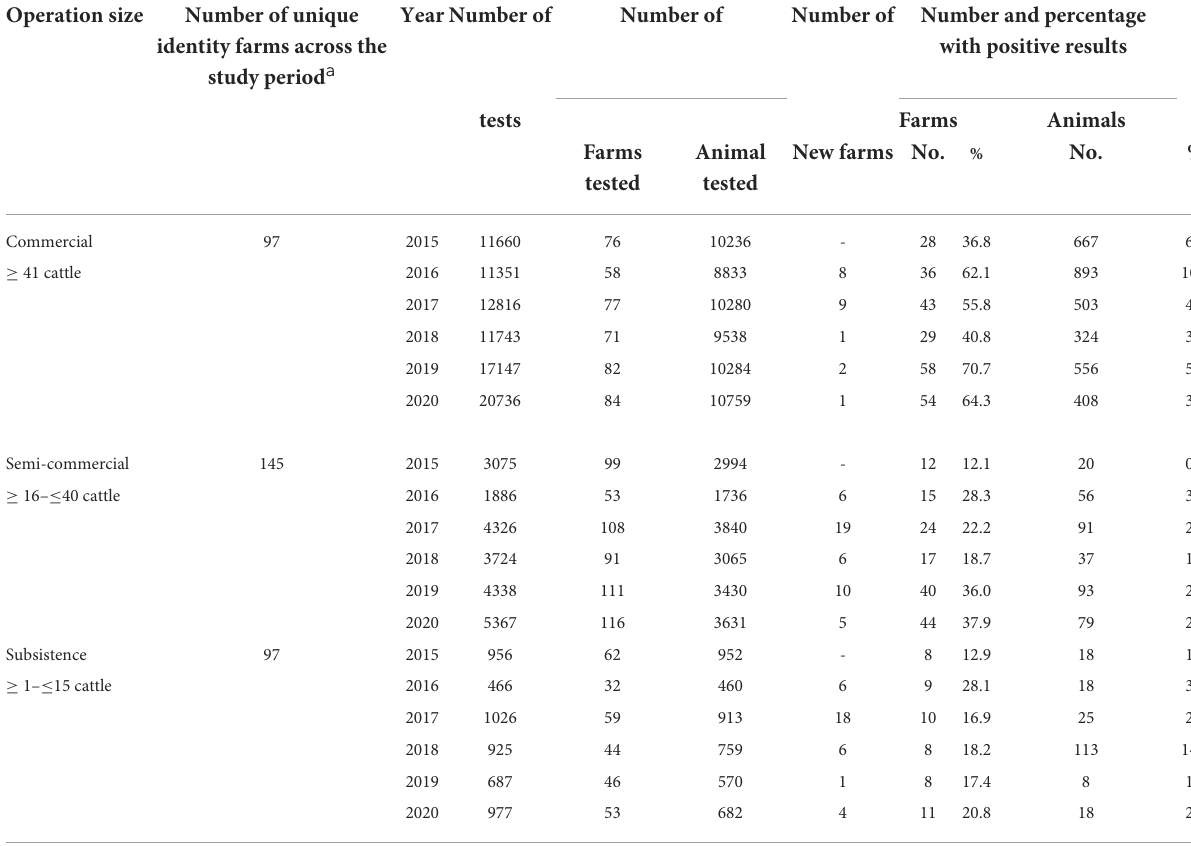
TABLE 6 Dairy farms in Central division by operation size: Number of tests, number of farms and animals tested for bTB by the Fiji BTEC program from 2015 to 2020. Operation size Number of unique